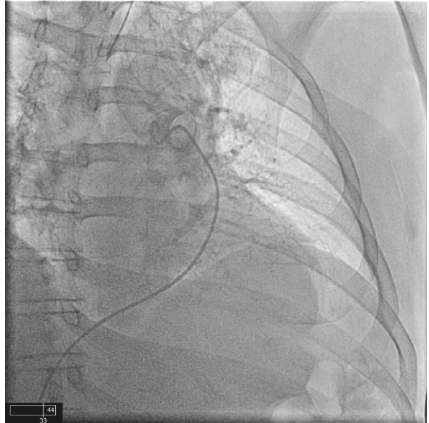
Figure 3: After injection with minimal perfusion of the left upper lobe and almost no perfusion of the left lower lobe.